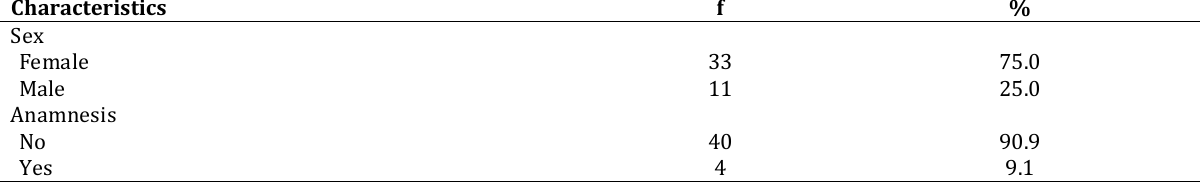
Table 1. Distribution of Sex and the Results of the Respondent's Anamnesis, 2017 (n = 44) Characteristics